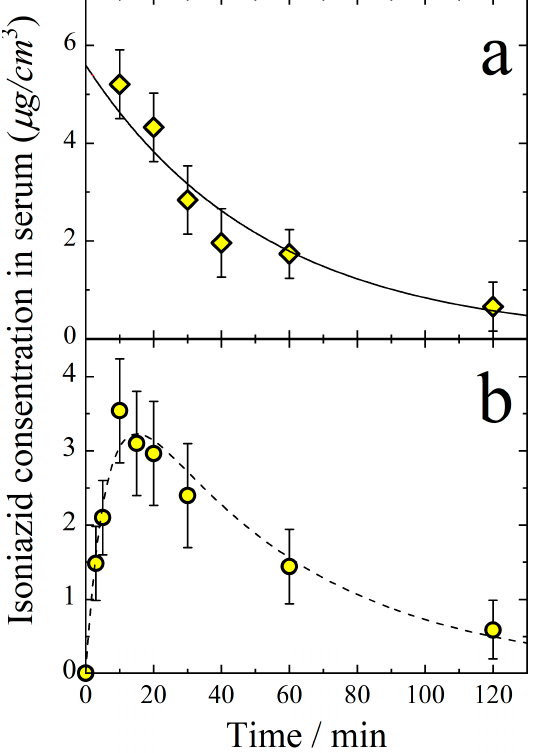
Figure 4. Temporal dependence of isoniazid concentration in the blood serum after intravenous ( a ) and per-oral ( b ) administration. The body-delivered dose is 5 mg/kg. Solid line follows the isoniazid concentration decay function C = exp( − k e t ) with k e = 0.019 min − 1 . Dash line follows Equation (18).